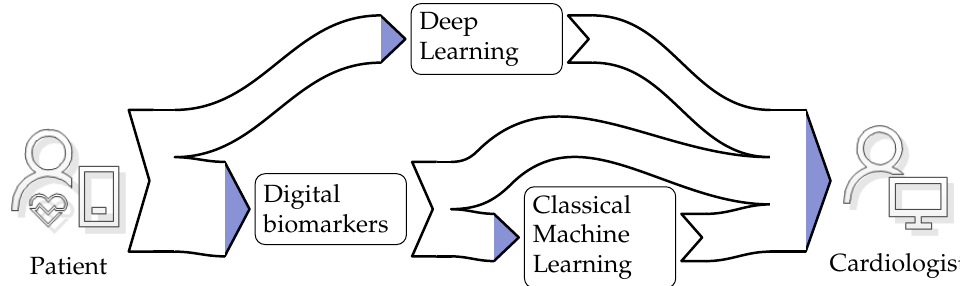
Figure 3. Information flow from patient to